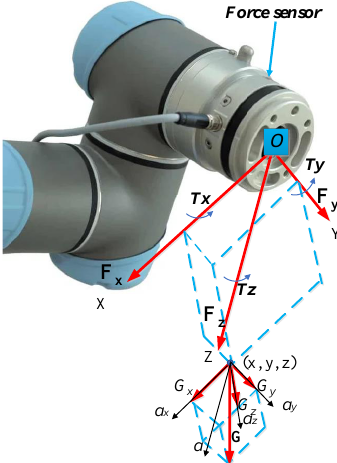
Figure 2. Schematic diagram of an online admittance controller with gravity compensation.